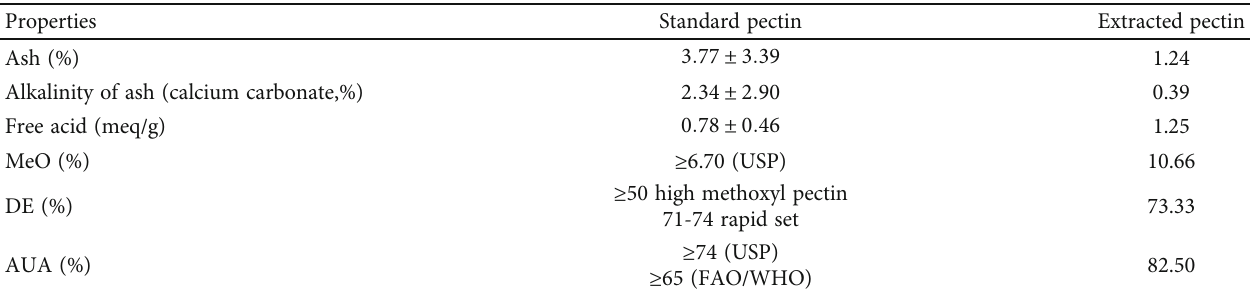
Table 5: Chemical properties of pectin obtained from watermelon rind compared with standard